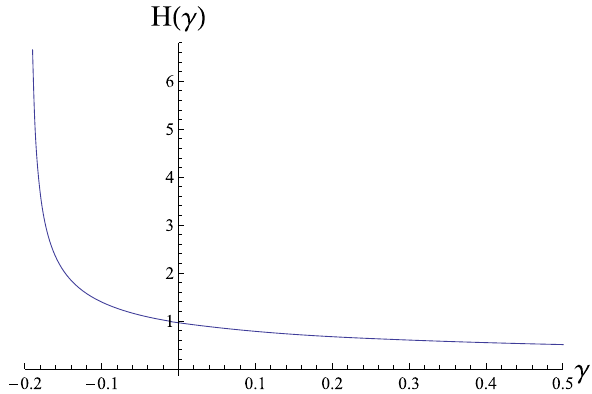
Fig. 7 An example of H calculated along near-extremal line r C ∼ r H . The calculation is performed with M = 1 and (cid:6) = − 0 . 03